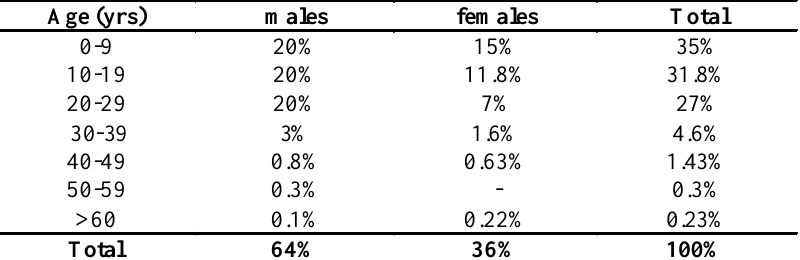
Table II : Age and Genderwise distribution of Salmonella